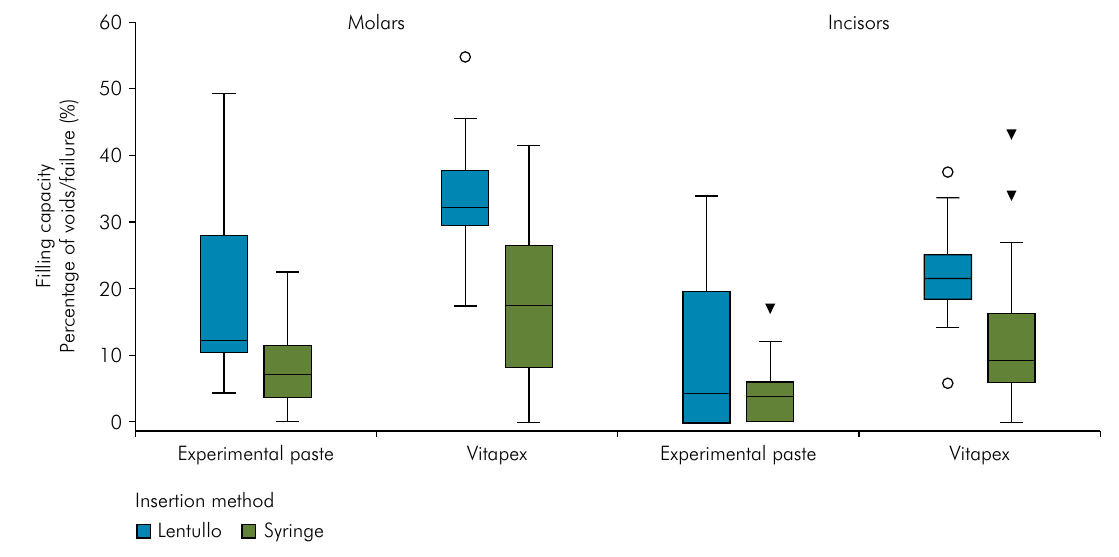
Figure. Regarding filling capacity, the voids and failure percentages of all